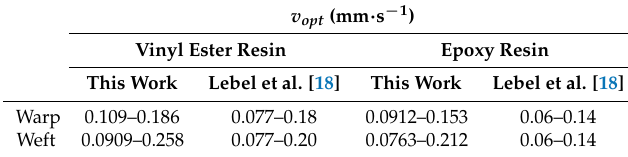
Table 3. Prediction of optimal injection velocities for TG15N fabric with different resins.